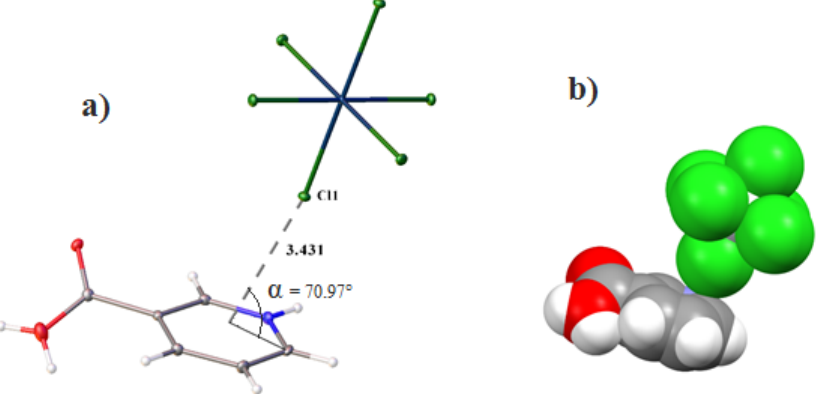
Figure 6. View showing halogen- π interactions in the structure I at 100 K (a) and "spacefill" image